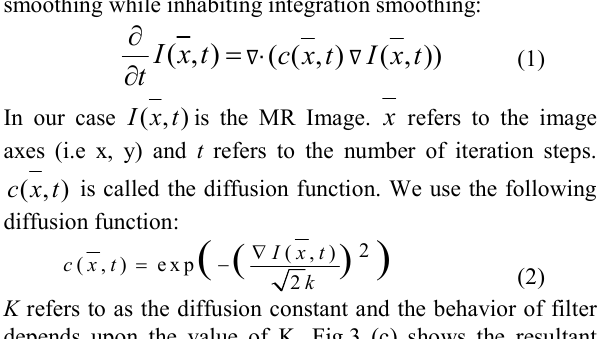
Fig.2 (a) Original Image, (b) Binary Head Mask, (c) Segmented Head Image